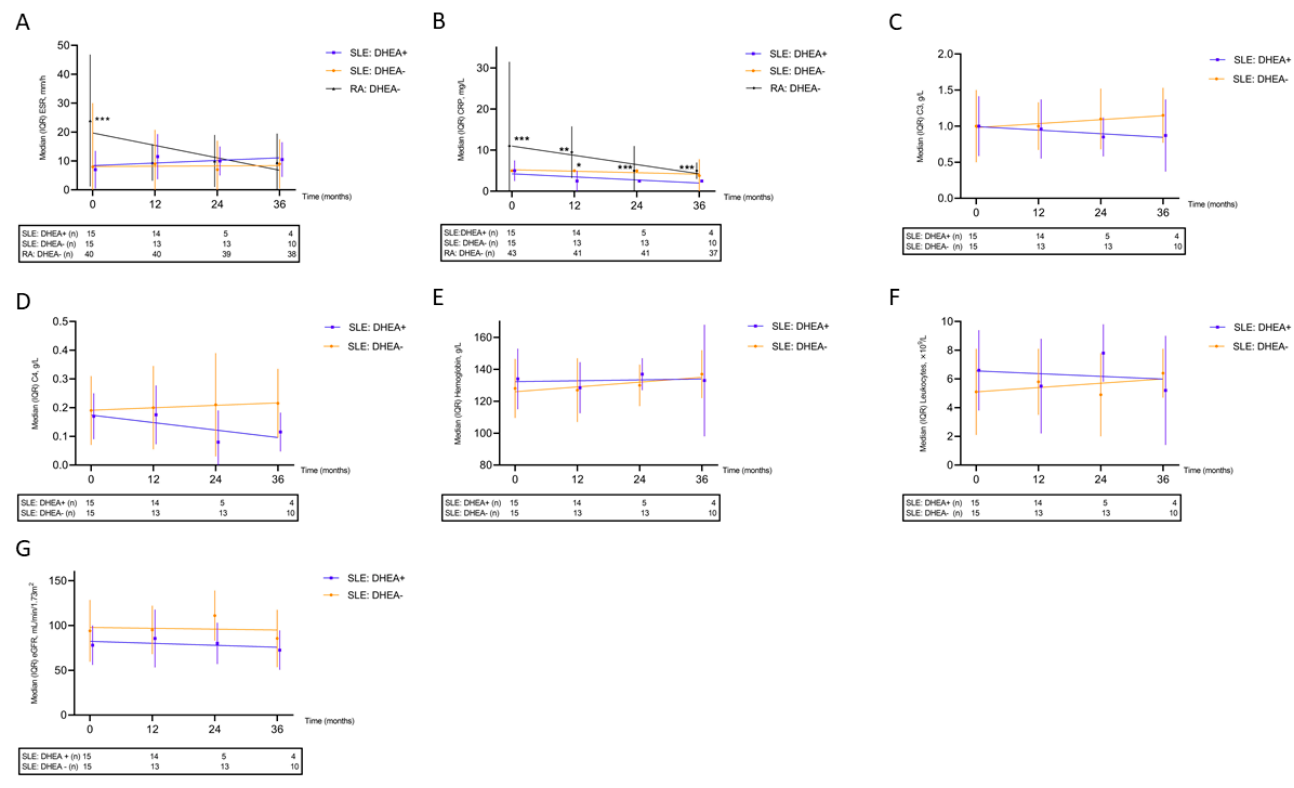
Figure 3. Longitudinal laboratory data demonstrated for patients with systemic lupus erythematosus (SLE) exposed/unexposed to DHEA and for sex- and age-matched controls with rheumatoid arthritis (RA); ( A ) erythrocyte sedimentation rate (ESR), higher in RA compared with both SLE groups; ( B ) C-reactive protein (CRP), higher in RA compared with DHEA-exposed SLE and higher among SLE controls than in DHEA-exposed SLE at 12 months; ( C ) Complement protein 3 (C3); ( D ) Complement protein 4 (C4); ( E ) Hemoglobin concentration; ( F ) Leukocyte count; ( G ) Estimated glomerular filtration rate (eGFR). * p < 0.05, ** p < 0.01, *** p < 0.005.